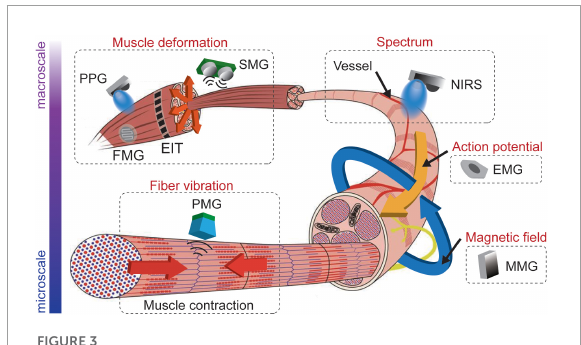
FIGURE3 Examples of myography sensing technologies from macroscale to